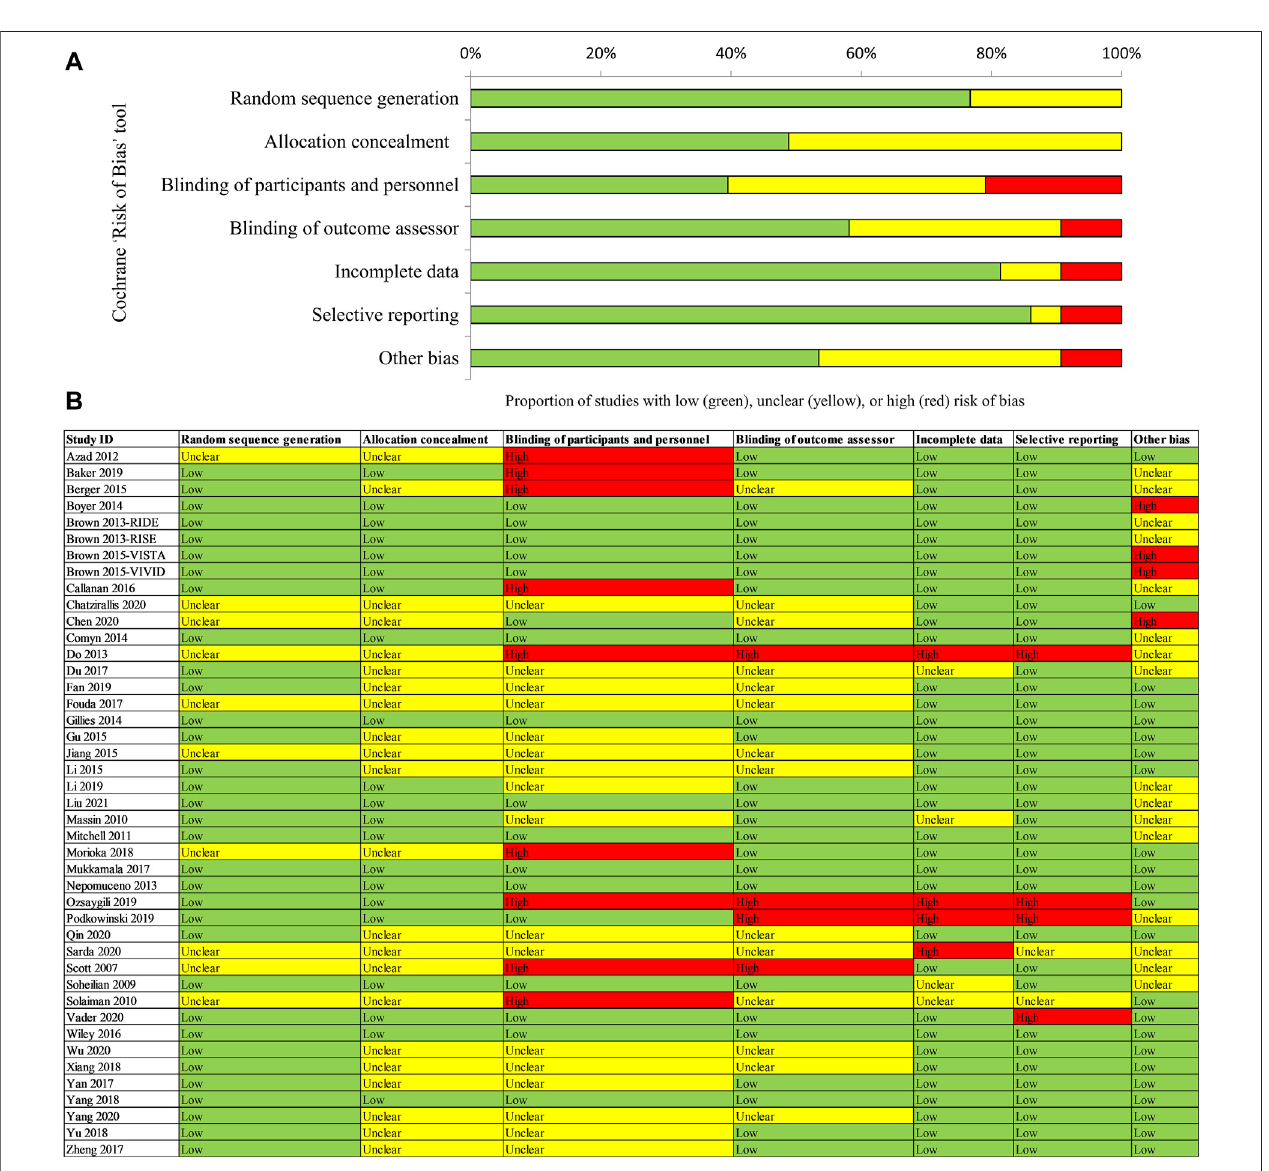
FIGURE 2 | Assessment of risk of bias for included RCTs [ (A) Risk of bias graph; (B) Risk of bias summary]. Notes: (A) Risk of bias graph: reviewers ’ judgements about each risk of bias item are presented as percentages across all randomized controlled trials (RCTs). (B) Risk of bias summary: reviewers ’ judgements about each risk of bias item for each included RCT. “ Low ” risk of bias in green, “ Unclear ” in yellow, and “ High ” risk of bias in red.